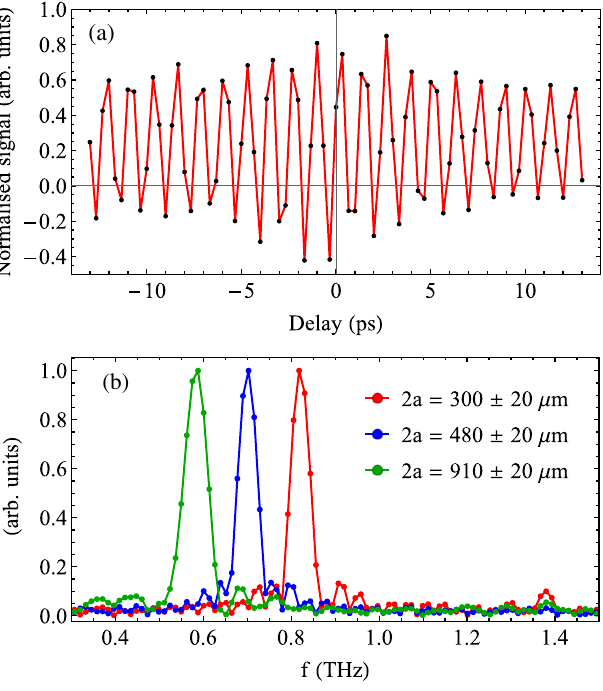
FIG. 3. (a) Interferogram for structure gap 2 a ¼ 300 μ m. (b) Example CCR power spectra calculated from corresponding interferograms forstructuregaps of 300 μ m, 480 μ m, and 910 μ